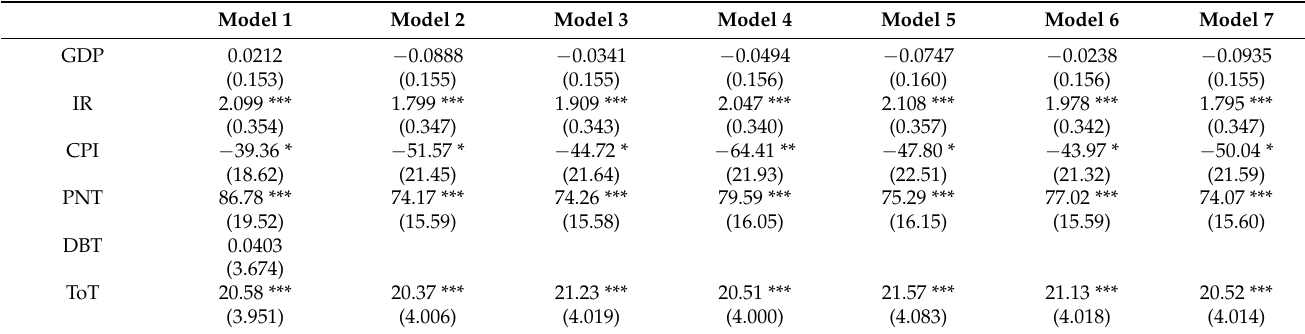
Table A17. Panel Regression Table Random-Effects OM Model 2